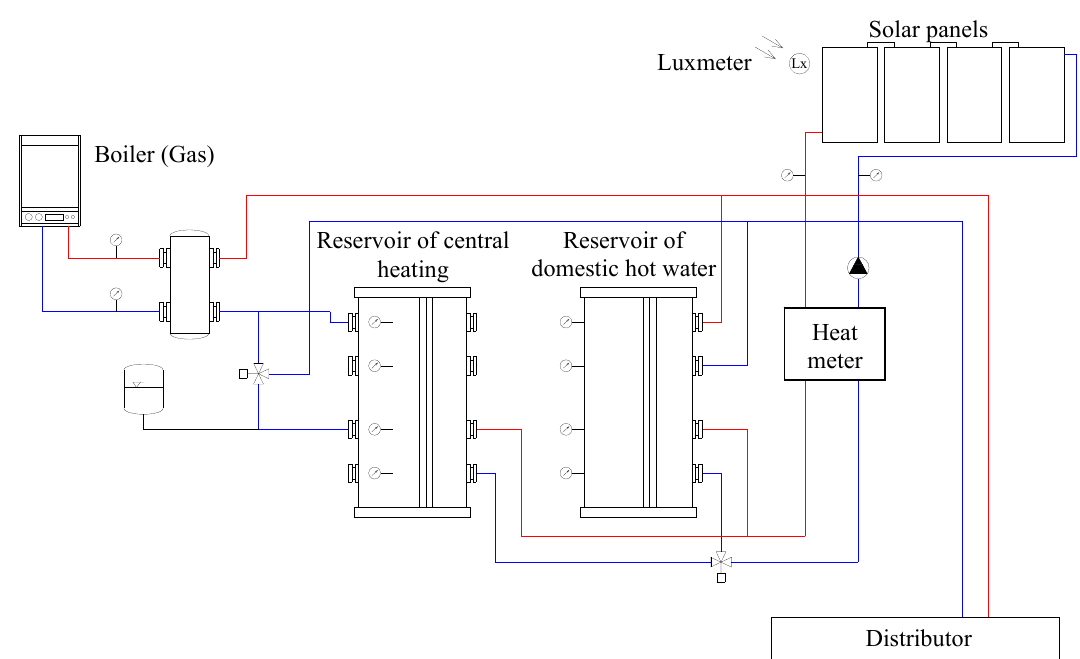
Figure 5. Diagram of a part of the multivalent laboratory system used in experiments. Blue line—inlet pipes (cold water), Red line—outlet pipes (heated water).